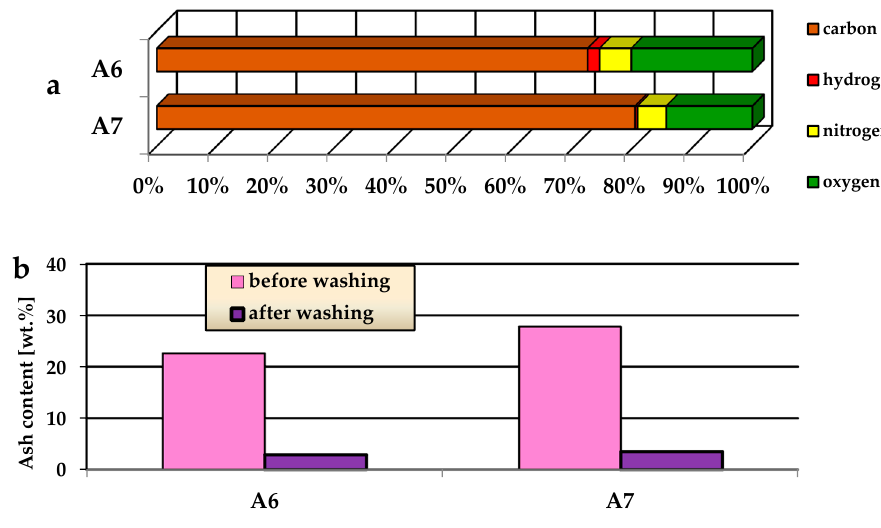
Figure 2. The elemental analysis ( a ) and ash content ( b ) of samples A6 and A7.